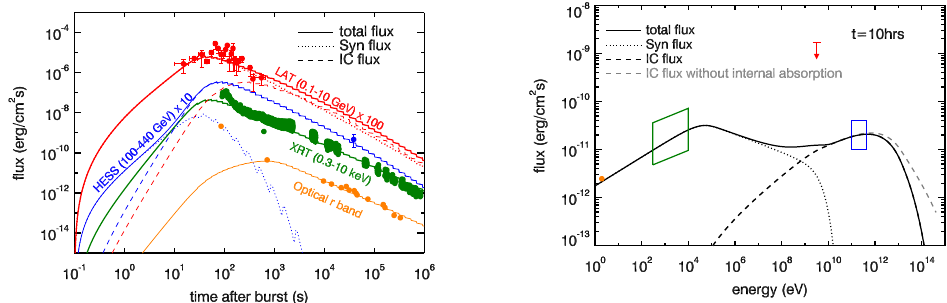
Figure 16. GRB180720B: modeling of the broad-band light curves ( left panel) and SED at the time of the H.E.S.S. detection ( right panel) proposed by [174]. Both the synchrotron and the SSC contribution to the total flux are shown (see legend). In the SED, X-ray and H.E.S.S. data are shown, respectively, with the green and the blue